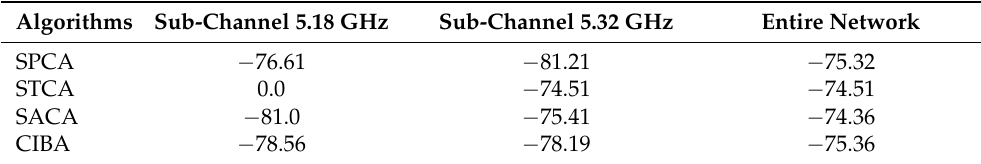
Table 2. Total interference power comparison of CIBA and other fixed channel allocation schemes for 15-node network topology